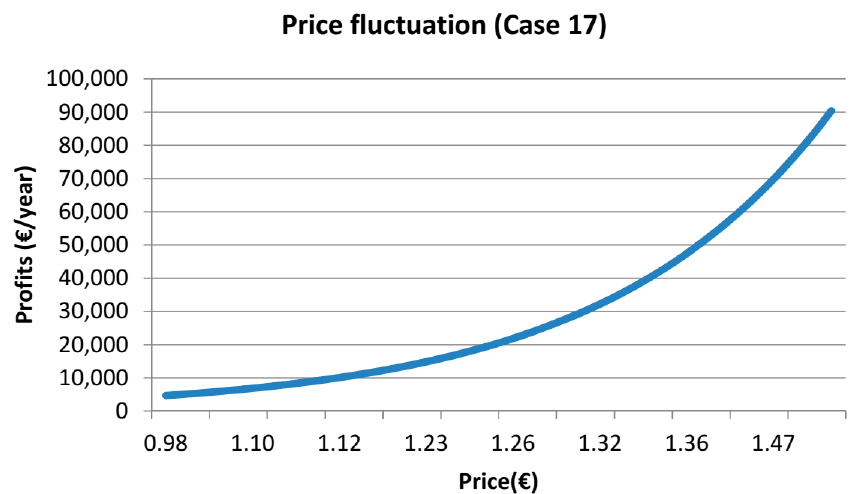
Figure 4. Profits obtained for product 2 and case 17 versus